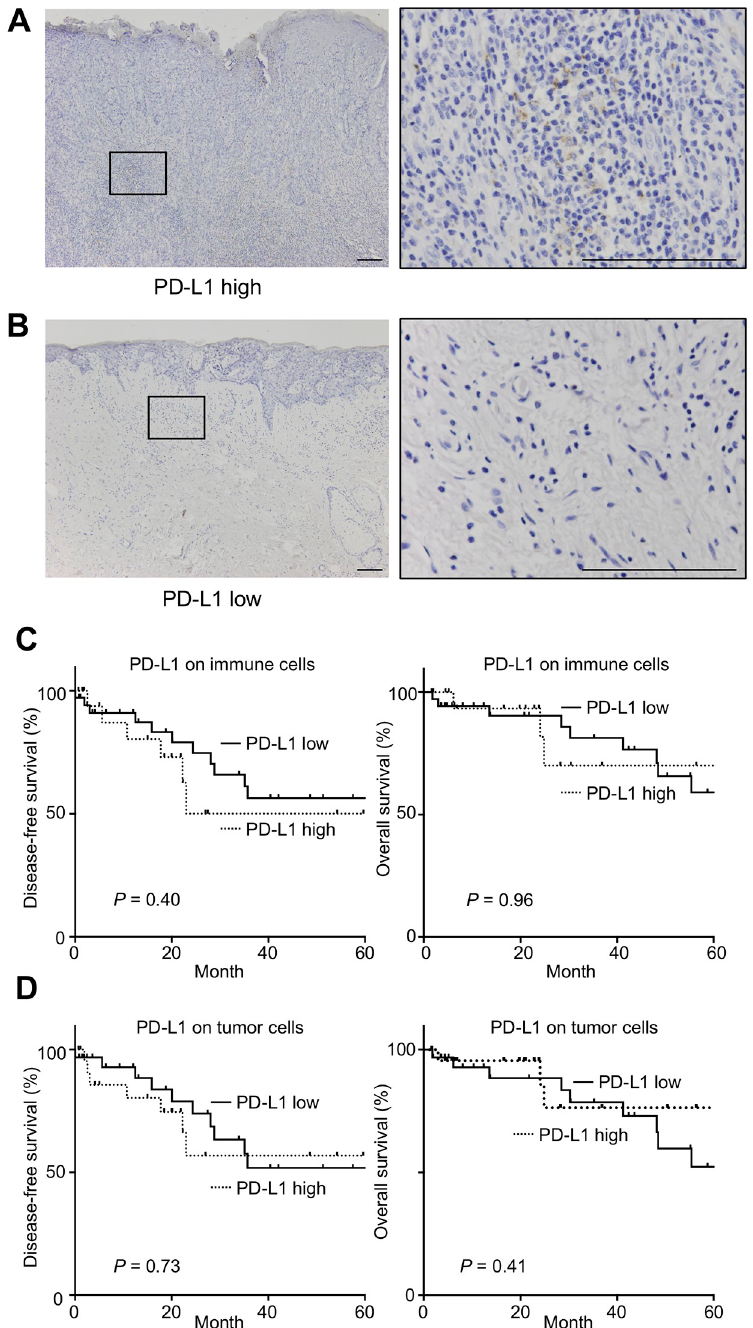
Fig 4. Kaplan-Meier curves of DFS and OS stratified by PD-L1 expression on immune cells and tumor cells. Representative IHC stainings of tumor specimens with high expression of PD-L1 on immune cells (A) and low expression of PD-L1 on immune cells (B) are shown. Scale bar, 100 μ m. Kaplan-Meier DFS and OS curves stratified by PD-L1 expression on immune cells (C) and PD-L1 expression on tumor cells (D) are shown (n = 54). The log-rank test was performed for the univariate